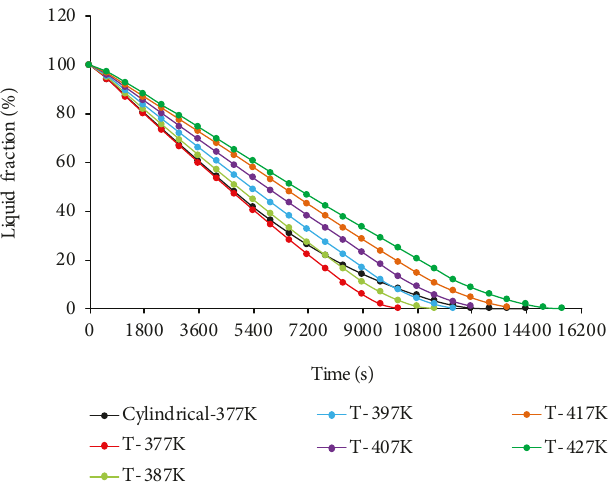
Figure 14: E ff ects of initial inlet temperature of HTF on liquid fraction.